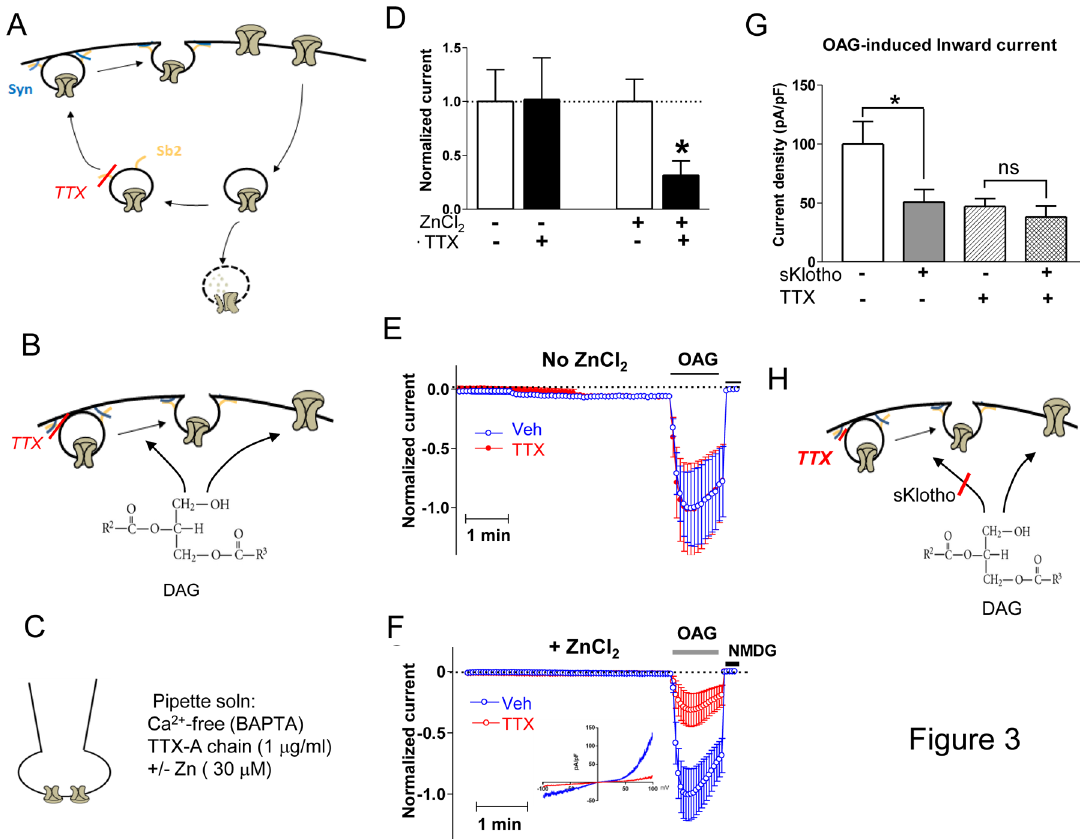
Fig 3. Soluble klotho blocks DAG stimulation of exocytotic insertion of pre-docked TRPC6 vesicles. (A, B) Tetanus toxin (TTX) acts on synaptobrevin (“Sb2” for synaptobrevin-2) to decrease surface expression of TRPC6 channels. The effect may occur at the level of recycling vesicles (panel A) or on pre-docked vesicles (panel B). (C) Diagram illustrating pipette solution used in whole-cell patch-clamp recording. (D) In the presence of ZnCl 2 , TTX-A chain (applied in patch pipette) decreased DAG-stimulated TRPC6 current. TTX-A chain has no effect in the absence of ZnCl 2 . Current density (at -100 mV) normalized to recording without ZnCl 2 and without TTX (first bar from left). Bar graph shows mean ± SEM, n = 6–8. � indicates p < 0.01 vs no TTX. (E, F) Time course of recordings showing effect of TTX in the absence of ZnCl 2 (panel E) or presence of ZnCl 2 (panel F). Inset in panel F shows I-V curves with Veh vs TTX. (G) Relationship between effect of TTX and soluble klotho on OAG-stimulated TRPC6 current. Bar graph shows mean ± SEM, n = 6–8. � indicates p < 0.01 as indicated. ns, statistically no significant. (H) Diagram illustrating site of action of TTX and sKlotho.